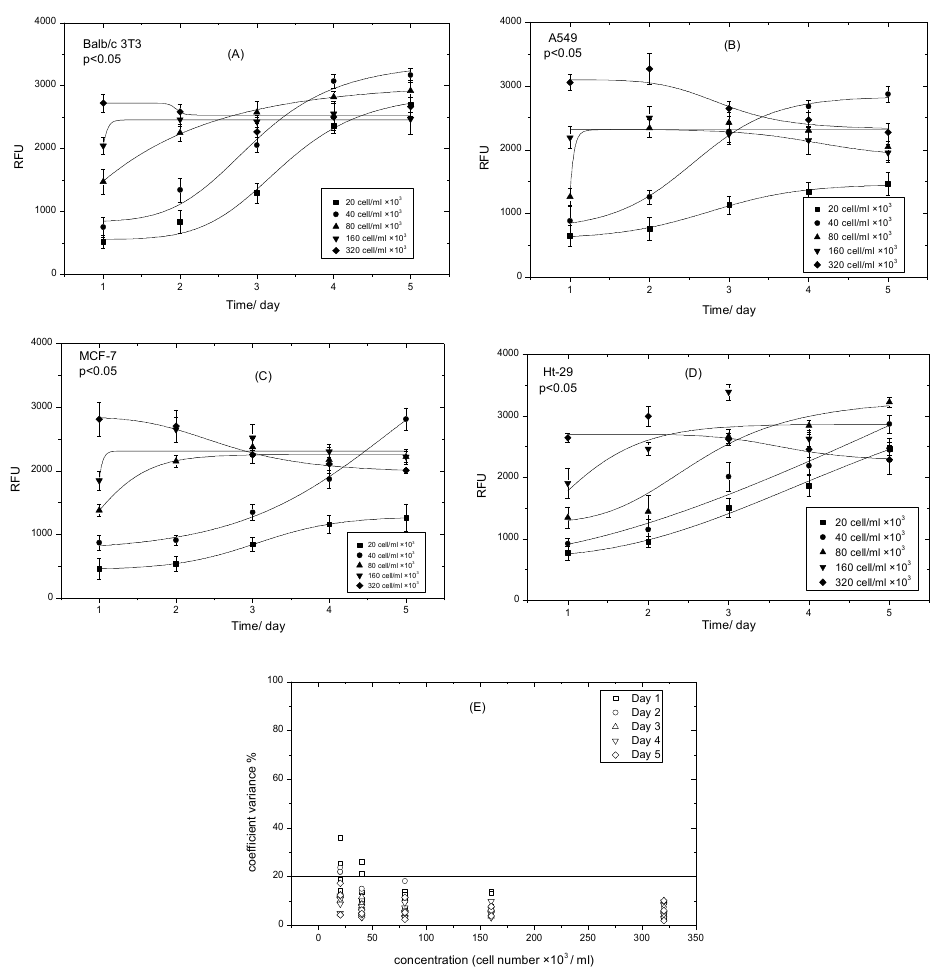
Figure 5. Logistic growth curves of the different cell densities at various cell lines over five days. ( A ) Balbc/3T3 cell lines; ( B ) A549 cell lines; ( C ) MCF-7 cell lines; ( D ) Ht-29 cell lines; ( E ) coefficient variance % of growth curves vs. cells numbers. Data are expressed as the mean ± SD of measurements of three independent experiments.